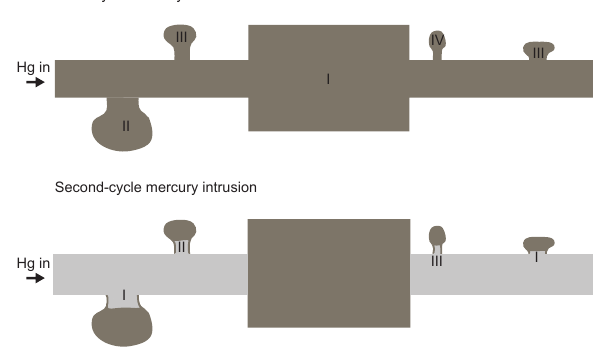
Figure 4. Conceptual model of first and second MIP cycle. Num- bers indicate the succession in pore filling, which is related to a stepwise increase in pressure, linked to a certain radius of a pore neck entrance. The second cycle indicates the remaining mercury from the first cycle.